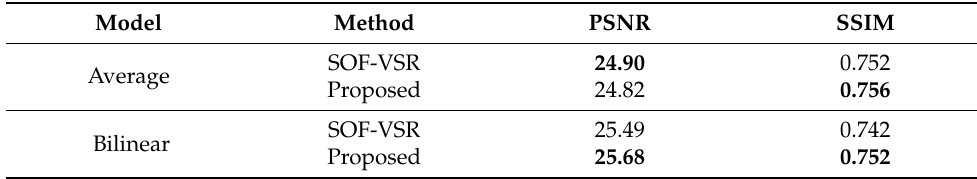
Table 3. The reconstruction results of × 4 scale of mean downsampling and bilinear downsampling with different methods of super-resolution. The best results are shown in boldface.